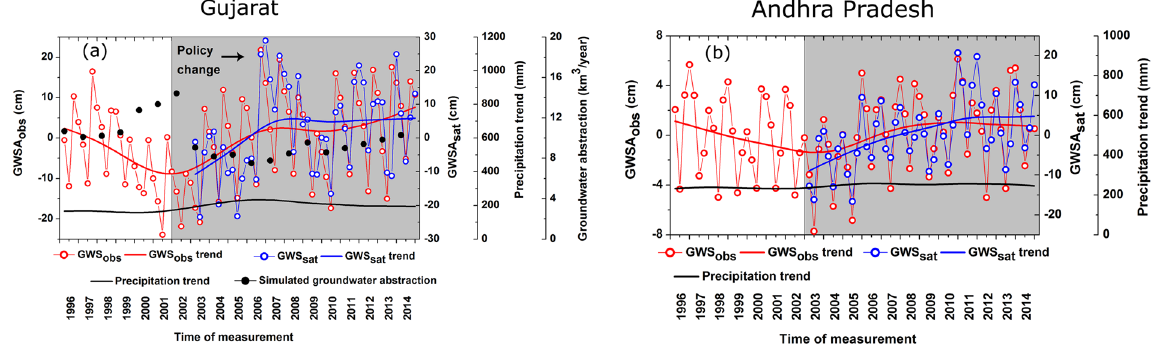
Figure 3. Annual GWSA obs , GWSA sat , and their Hodrick-Prescott (HP) trends for ( a ) Gujarat (in HMZ B) and ( b ) Andhra Pradesh (in HMZ E). The grey area represents the time-period for implementation of groundwater management policy change. Change in simulated groundwater abstraction from PCR-GLOBWB simulation for Gujarat is shown in ( a ). Precipitation HP trends are shown using black